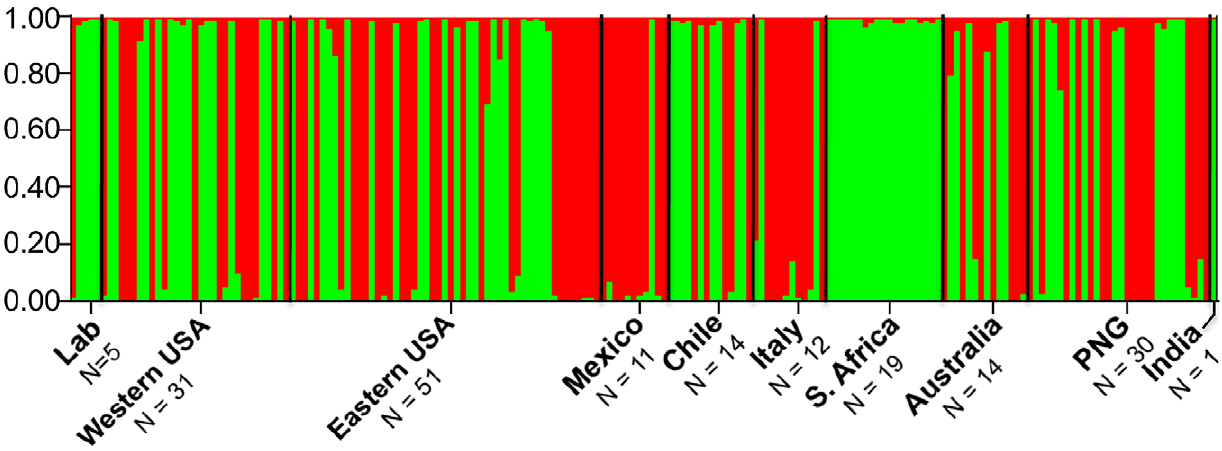
Figure 1. Two cluster population structure of T.vaginalis . A Bayesian clustering model implemented in STRUCTURE 2.2 indicates a two-cluster population structure for T. vaginalis (N=188). The green cluster (type 1, (N=95)) and red cluster (type 2, (N=93) are found in each geographical location, with the exception of Southern Africa where all samples are type 1, and Mexico, which has a statistically significant over-representation of type 2. PNG: Papua New Guinea. Isolates included in each geographical location can be found in Table S1 .